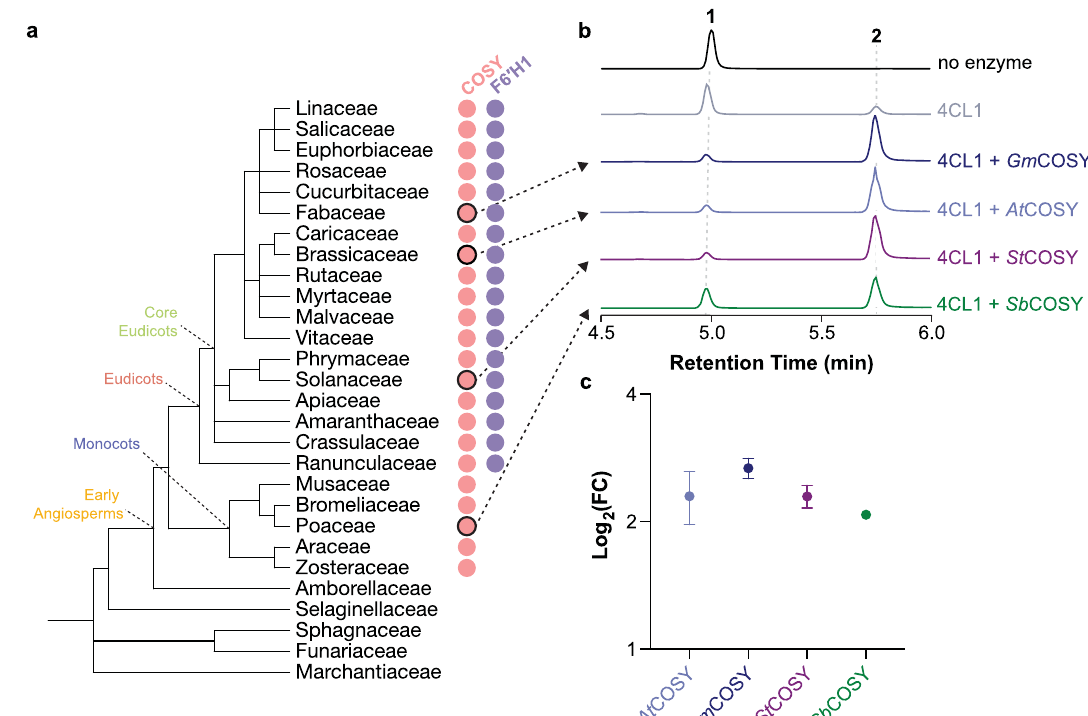
Fig. 5 | Evolutionary origins of COSY in land plants. a Presence of COSY (pink circles) and F6 ′ H1 (purple circles) orthologs among major lineages of land plants. This information is inferred from maximum-likelihood phylogenetic analyses of COSY and F6 ′ H1 together with their homologs from representative plants with sequenced genomes (Supplementary Figs. 28 and 29). b Combined LC-MS XICs of 165.05556 m / z ; 1 , 209.04549 m / z ; 1 and 191.03443 m / z ; 2 showcasing the in vitro